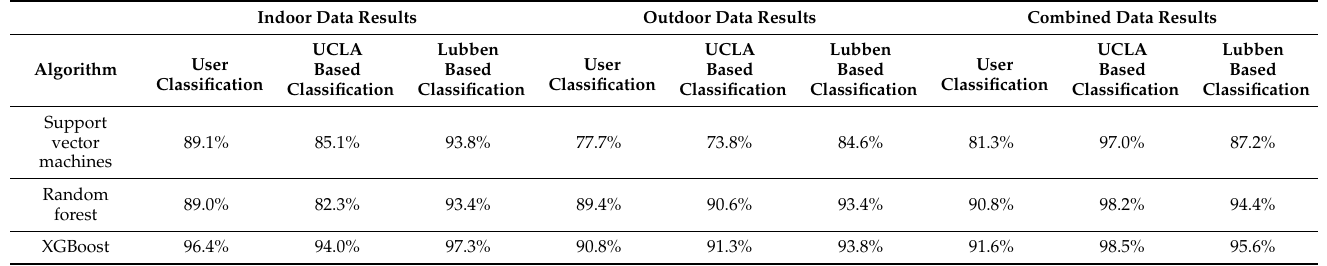
Table 6. Result of machine learning algorithms on indoor and outdoor